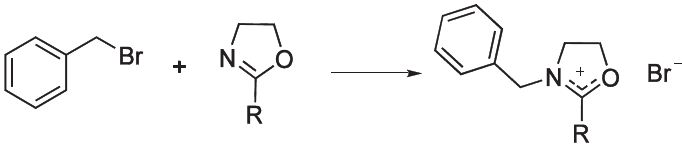
Figure 20. Initiation by covalent reagents.